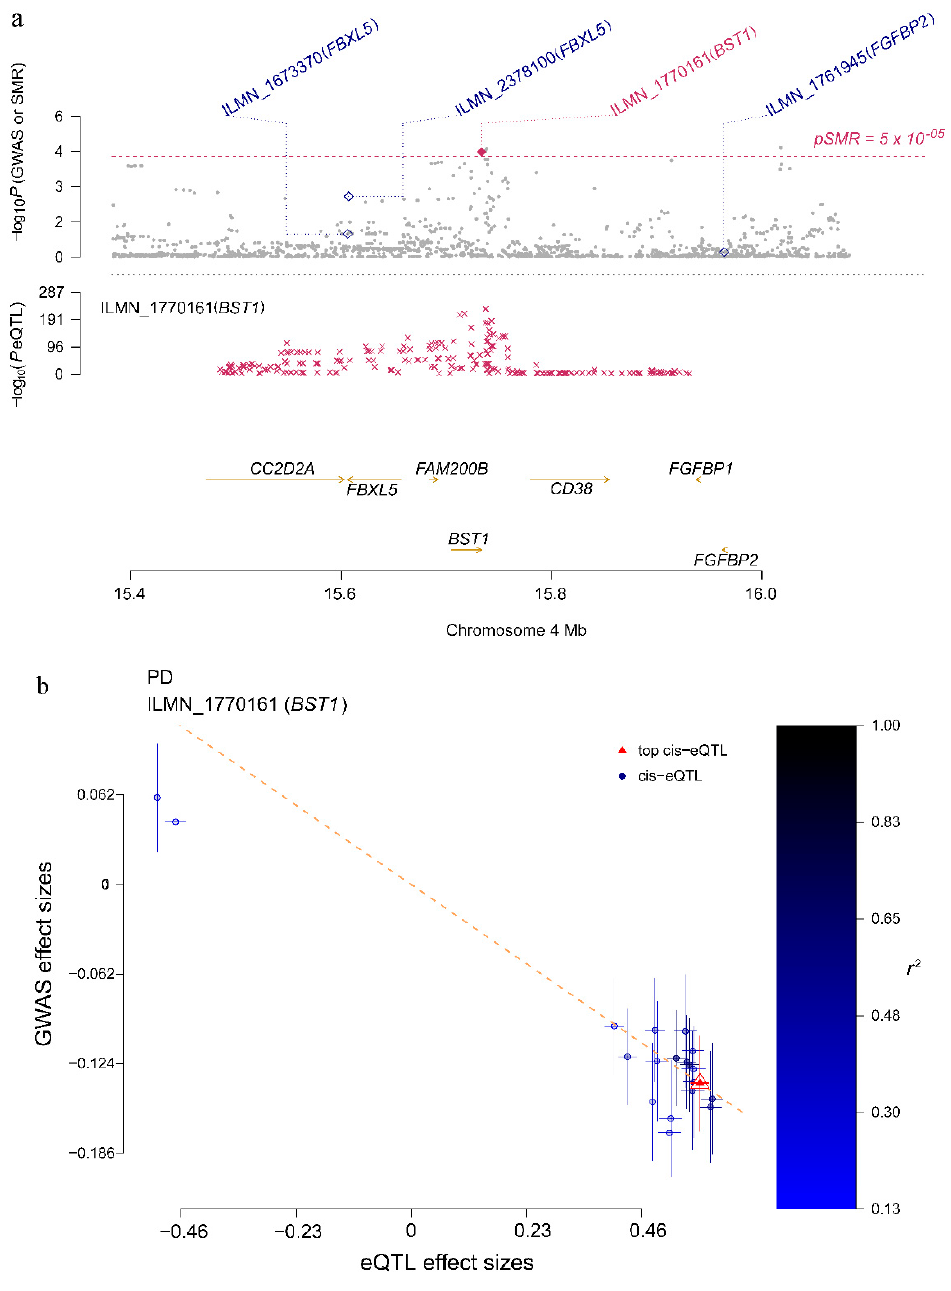
Figure 5. BST1 locus for PD. ( a ) The abscissa represents the coordinate axis on the chromosome interval. In the top graph, the brown dots indicate the p -values of each SNP in the GWAS meta-analysis, and the diamonds indicate the p -values of the probes in the SMR test. The figure below refers to the p -value of the cis-eQTL-labeled BST1 probe in eQTL data. BST1 loci that passed the SMR and HEIDI tests are highlighted with red dots. ( b ) The e ff ect sizes of SNPs from GWAS and eQTL e ff ects of SNPs. The orange dotted line indicates the most significant cis-eQTL e ff ect value b xy , and b xy < 0 indicates that gene expression is negatively correlated with PD risk.